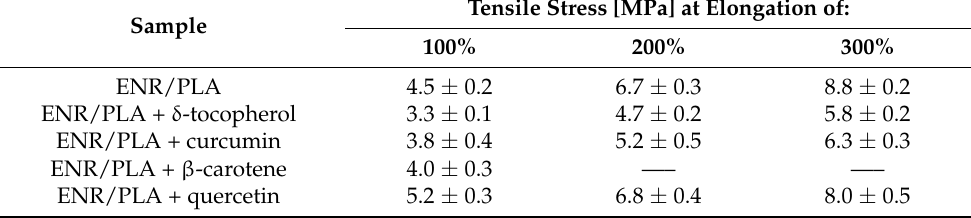
Table 2. Tensile stress at elongation of 100%, 200%, 300% for the unfilled and filled ENR/PLA blend samples.